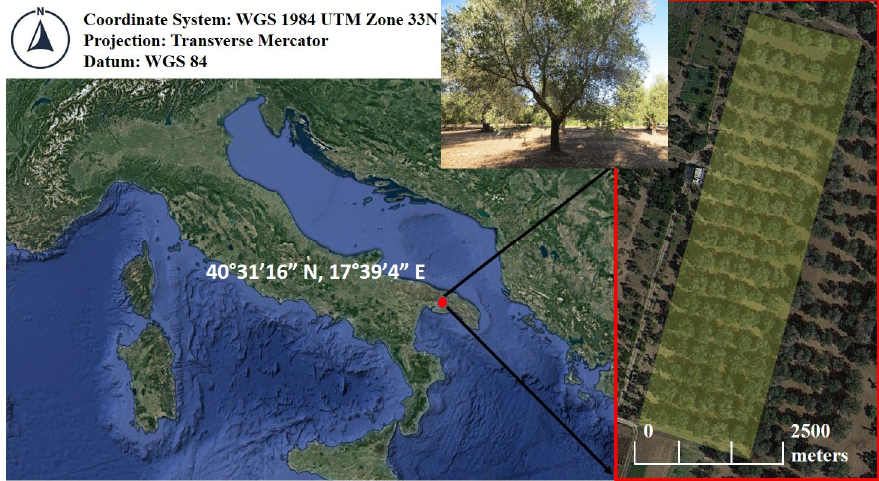
Figure 1. Localization of the study site in the Apulia region (south-eastern